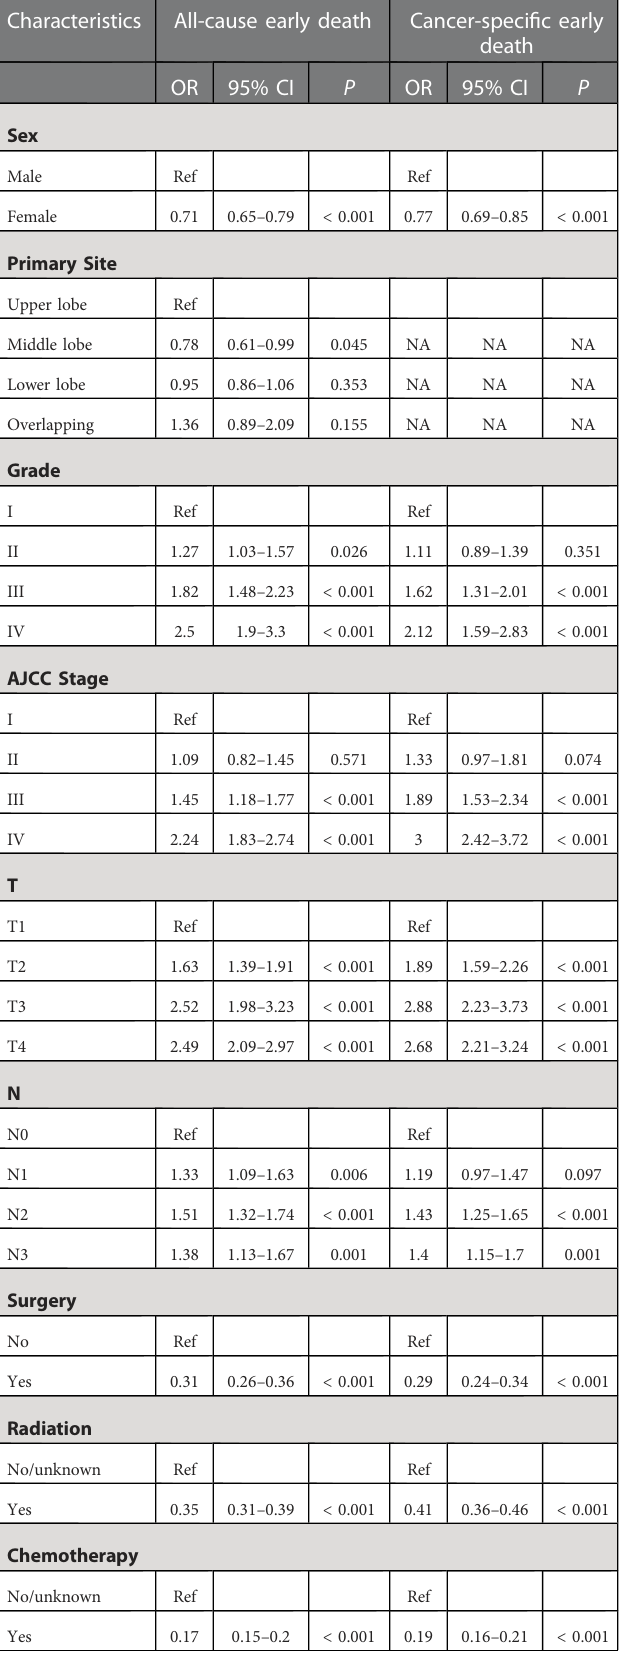
TABLE 4 The multivariate logistic regression analysis of all-cause and cancer-speci fi c early death in elderly LC patients.